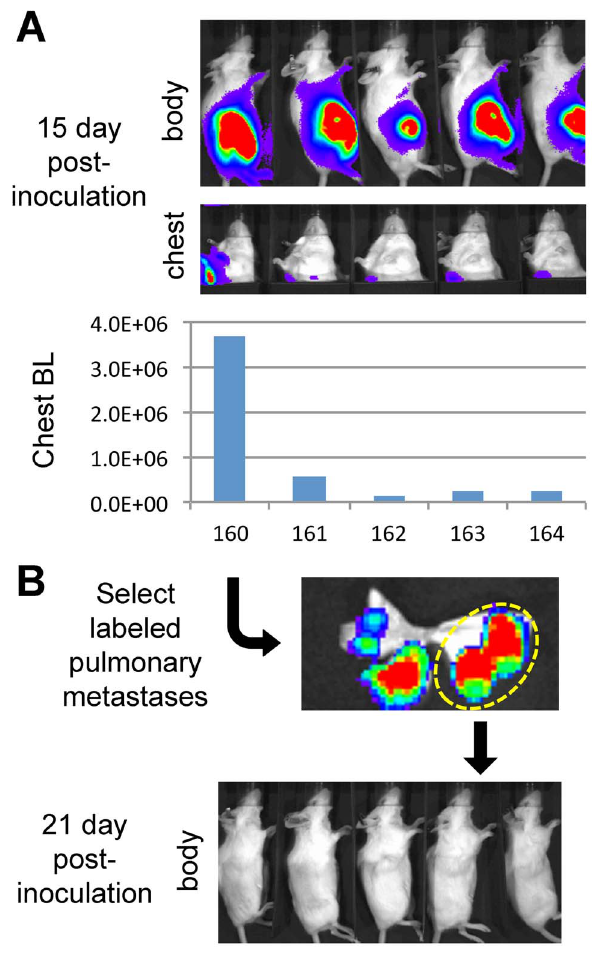
Figure 1. Inconsistency of ffLuc-eGFP reporter activity in labeled tumors during passages in syngeneic immunocompe- tent mice. A , Murine Lewis Lung Carcinoma (LLC) cells were infected with ffLuc-eGFP-expressing lentivirus ex vivo , and subcutaneously transplanted into five syngeneic albino C57BL/6 (c-Brd) mice ( # 160– 164). Reporter activity was monitored by BL imaging of subcutaneous tumor growth (body) and pulmonary metastasis (chest). At day 15 after inoculation, a metastatic BL signal was found in one of the mice ( # 160 in the lower panel). B , The lung was harvested from # 160, and a single glowing metastatic nodule selected using ex vivo imaging (upper panel) was transplanted into five c-Brd mice in the second passage. Imaging results showed that the reporter activity could not be consistently maintained in the resulting palpable tumors (lower panel).